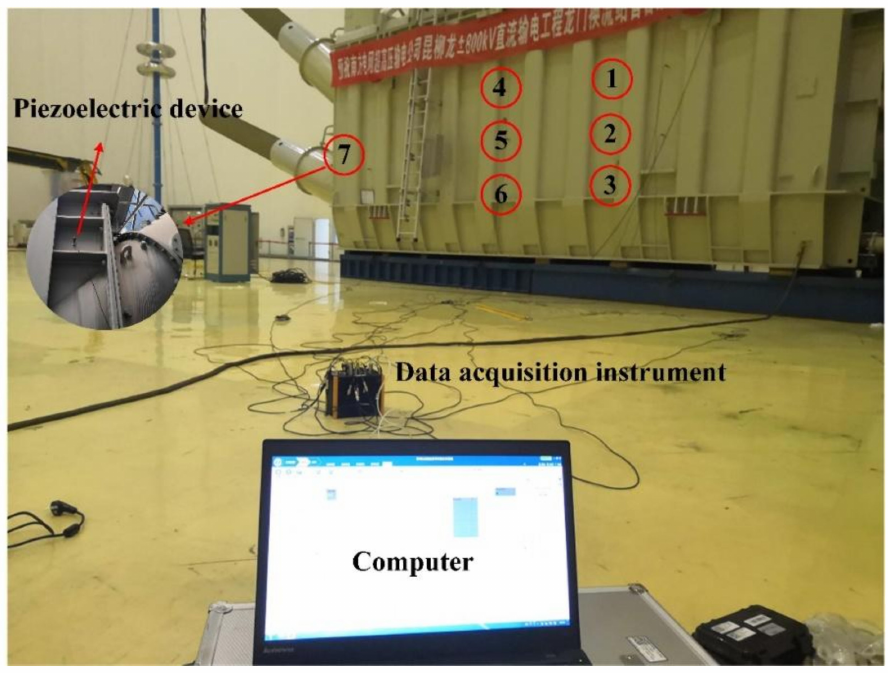
Figure 3. The field experiment on the vibration signal measurement of converter